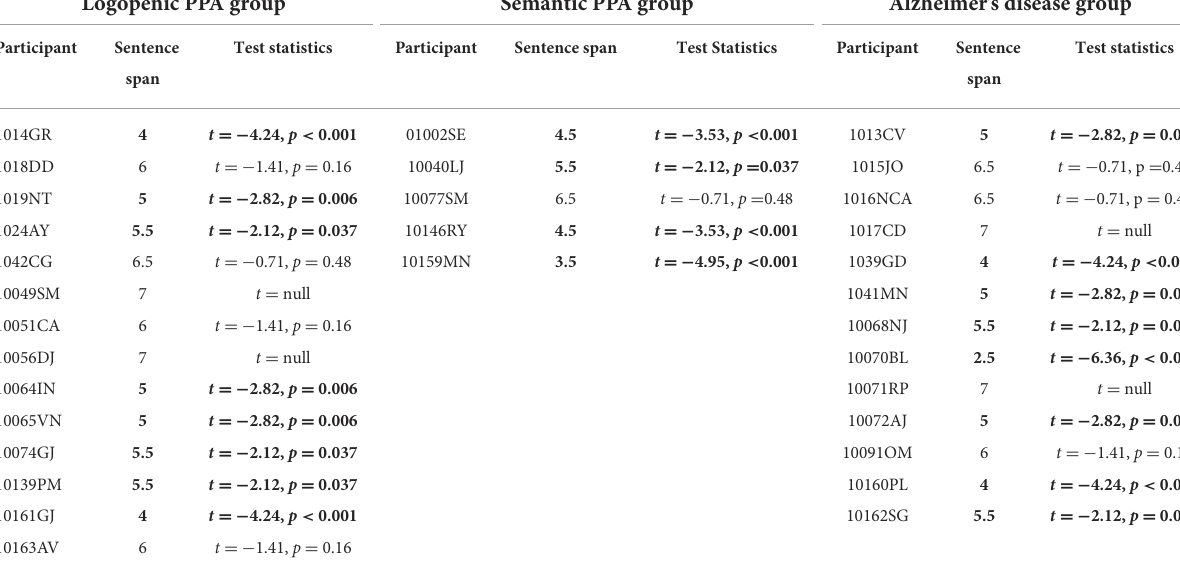
TABLE 3 Case-control comparisons computed per individual in the diagnostic group of participants. Logopenic PPA